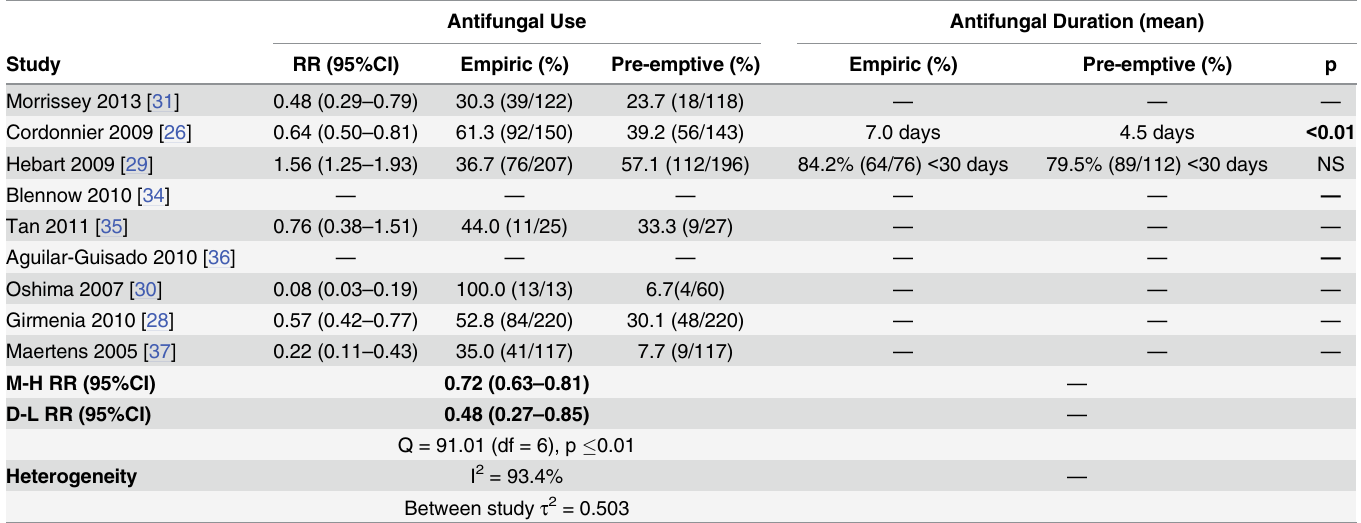
Table 3. Comparison of antifungal use in empiric versus pre-emptive antifungal therapy in high-risk neutropenic patients. Antifungal Use Antifungal Duration